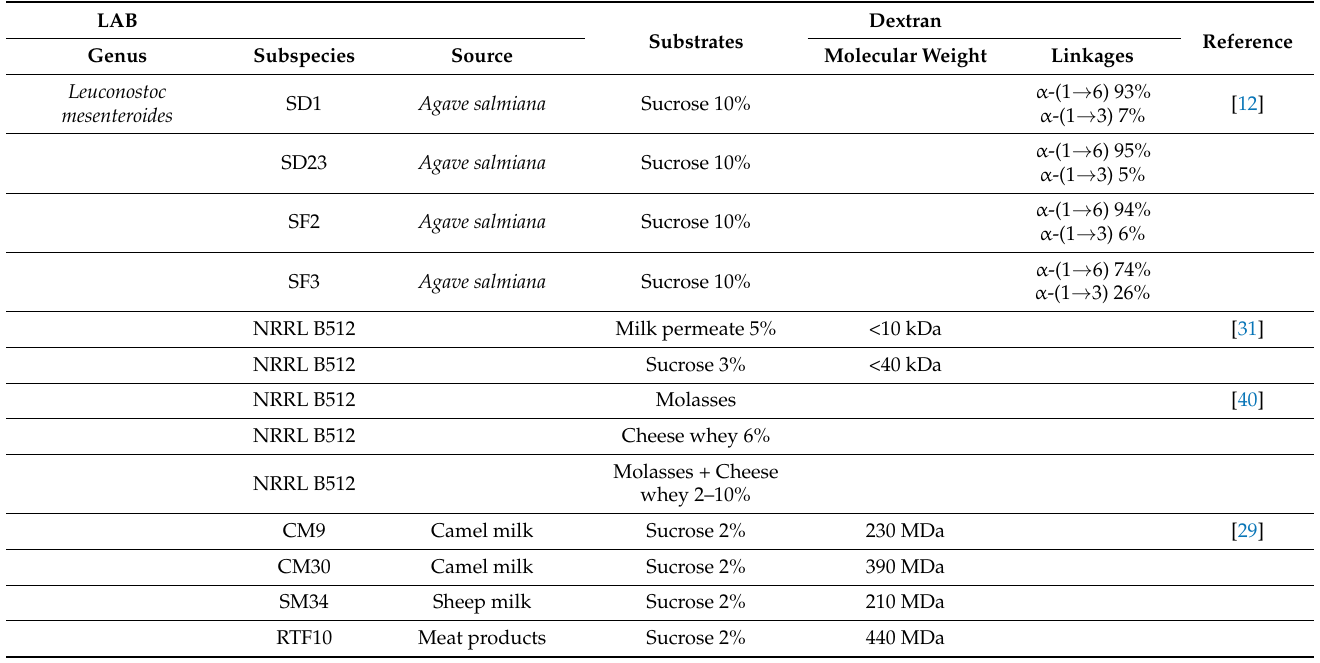
Table 1. Dextrans synthesized by lactic acid bacteria (LAB) isolated from different